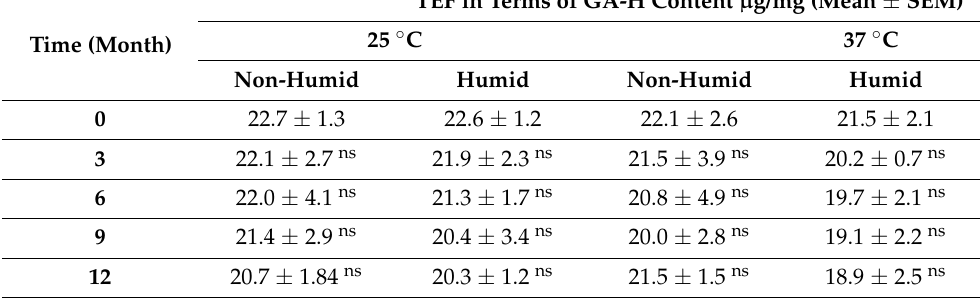
Table 3. Real-time stability analysis at 25 and 37 ◦ C (non-humid and humid conditions at specified times 0, 3, 6, 9, and 12 months of TEF of G. lucidum in terms of GA-H ( µ g/mg) equivalent.